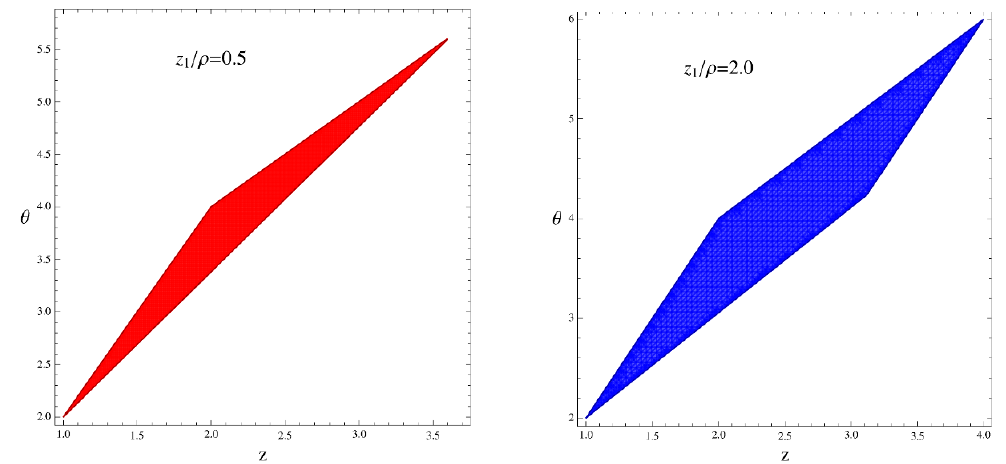
Figure 9 . The shaded areas denote the allowed ranges of f (cid:18); z g after considering the con- straint (5.19). The range of the parameter space depends on the ratio z 1 =(cid:26)